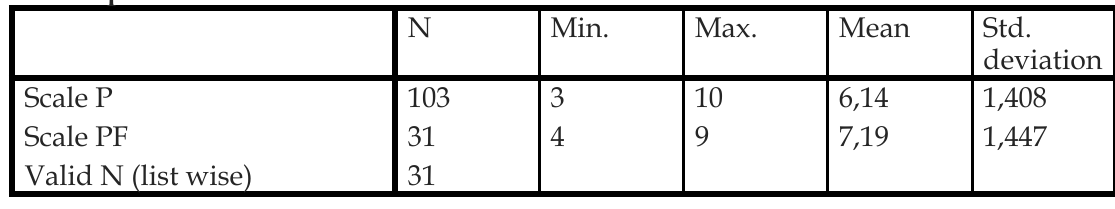
Table 3. Average level of positive orientation in the compared groups.